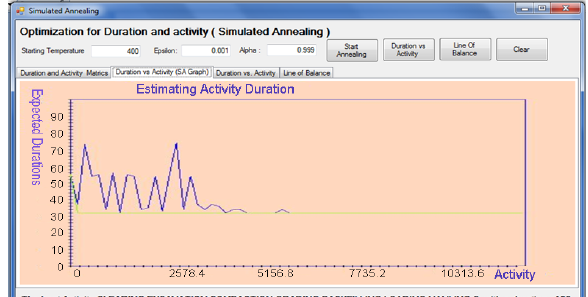
Table 3. Comparison of cost results per stage (2012 values)